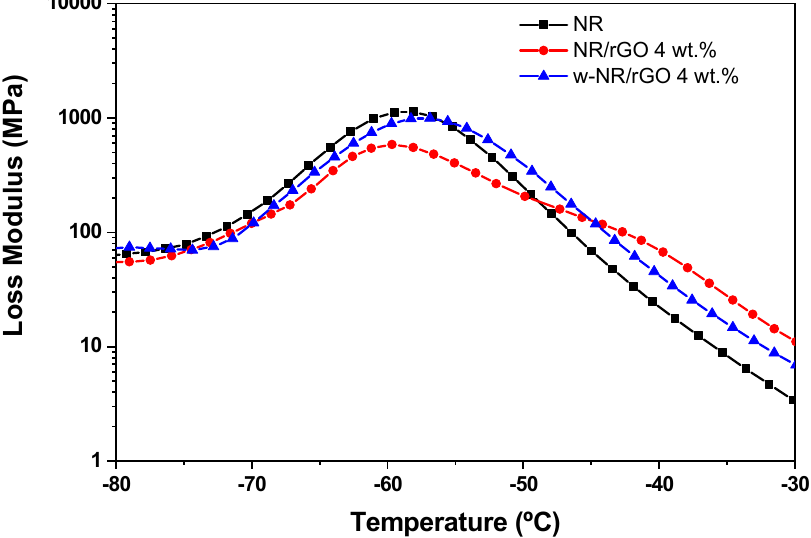
Figure 6. Loss modulus of NR, NR/rGO 4.0 wt.% and w-NR/rGO 4.0 wt.%.